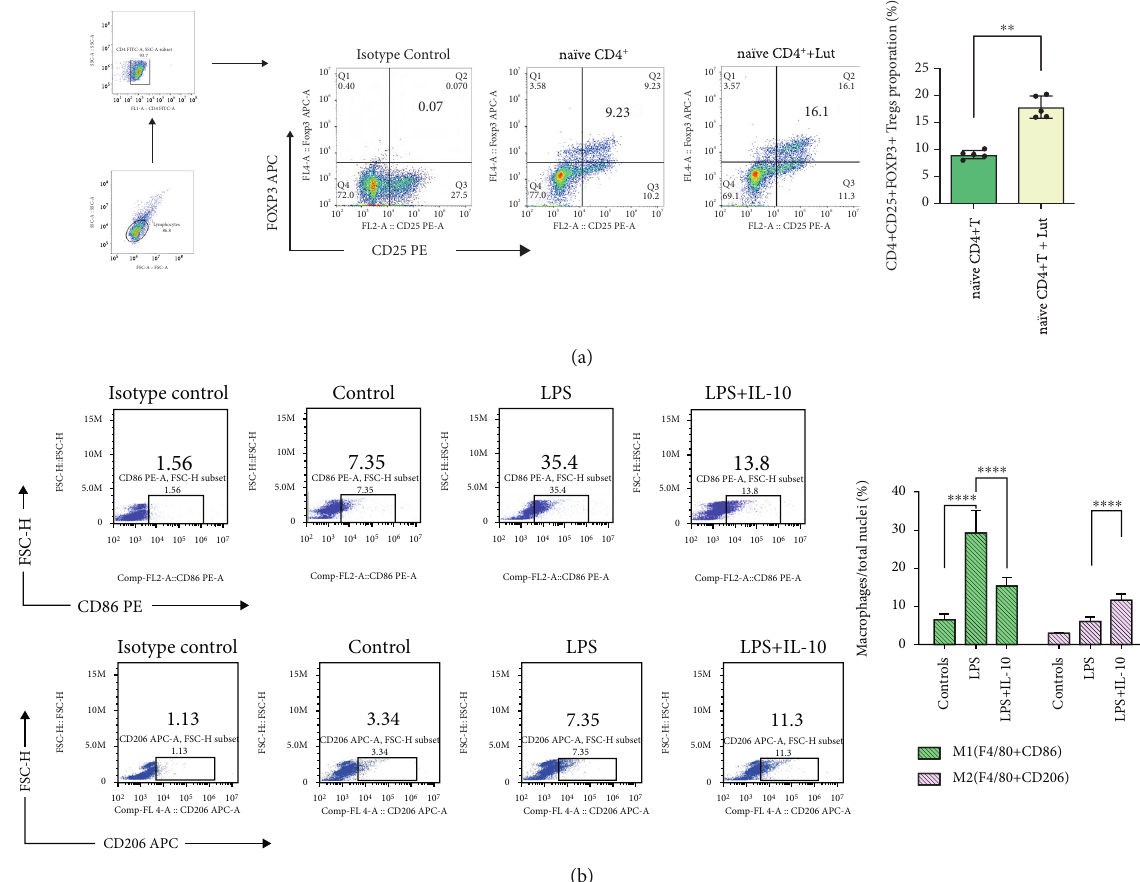
Figure 5: Luteolin promotes the di ff erentiation of naïve CD4 + T cells into Tregs, and IL-10 improves the polarization of M1/M2 macrophages. (a) Luteolin signi fi cantly promotes the di ff erentiation of naïve CD4 + T cells into CD4 + CD25 + FOXP3 + Tregs. Naïve CD4 + T cells were sorted from the spleen of wild-type C57BL/6 mice and cultured as described in Materials and Methods. Tregs were detected by fl ow cytometry on day 4. (b) IL-10 a ff ects the polarization of M1/M2 macrophages. Proportions of M1/M2 macrophages were examined by fl ow cytometry on day 3. Each group n = 5 , experiments are repeatable, and the most representative one was shown. Data of the column graphs are presented as means ± SD . ∗∗ p < 0 : 01 and ∗∗∗∗ p < 0 : 0001 comparing the control, LPS, and LPS+IL-10 groups, as calculated by one-way ANOVA followed by the LSD multiple comparison